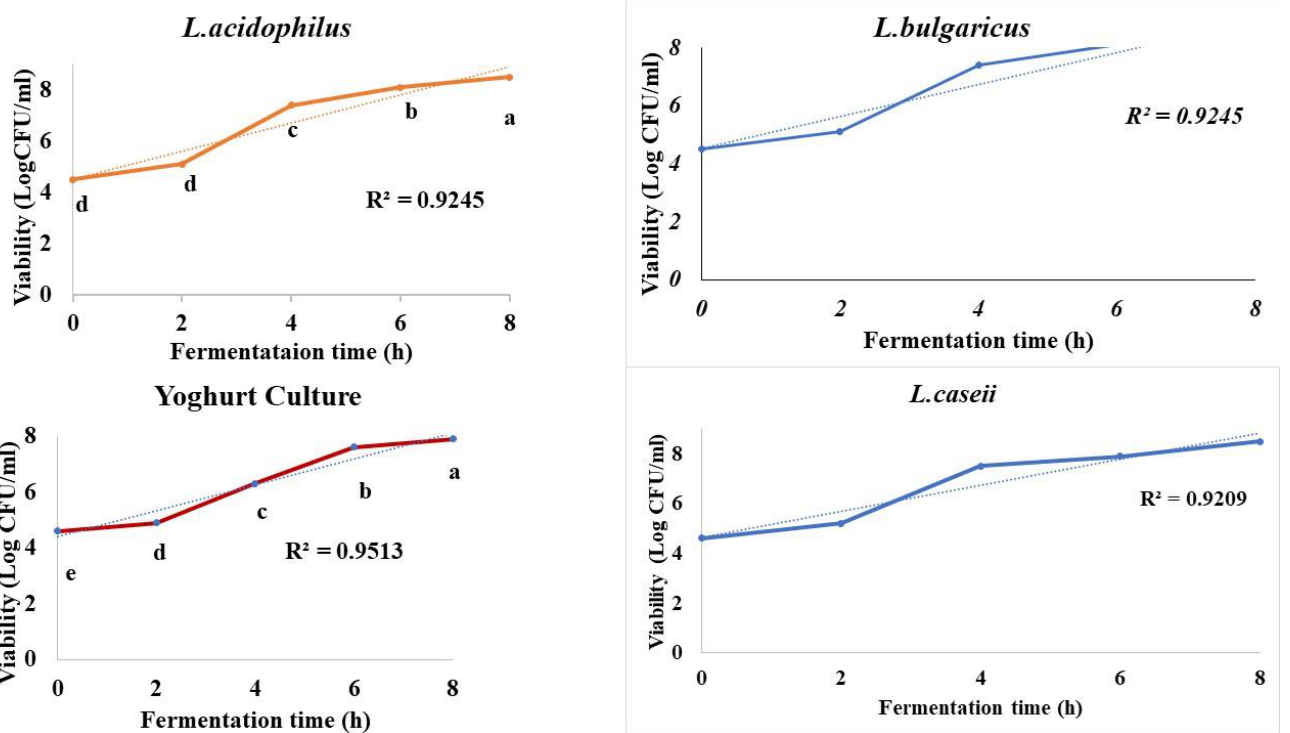
Figure 1. Viability (Log CFU/mL) of the three LAB strains against commercially yogurt culture (con- trol) during broken rice fermentation at 37 °C. Small letters (a – e) pointed to a significant difference (control) during broken rice fermentation at 37 ◦ C. Small letters (a–e) pointed to a significant difference ( p < 0.05). ( p <